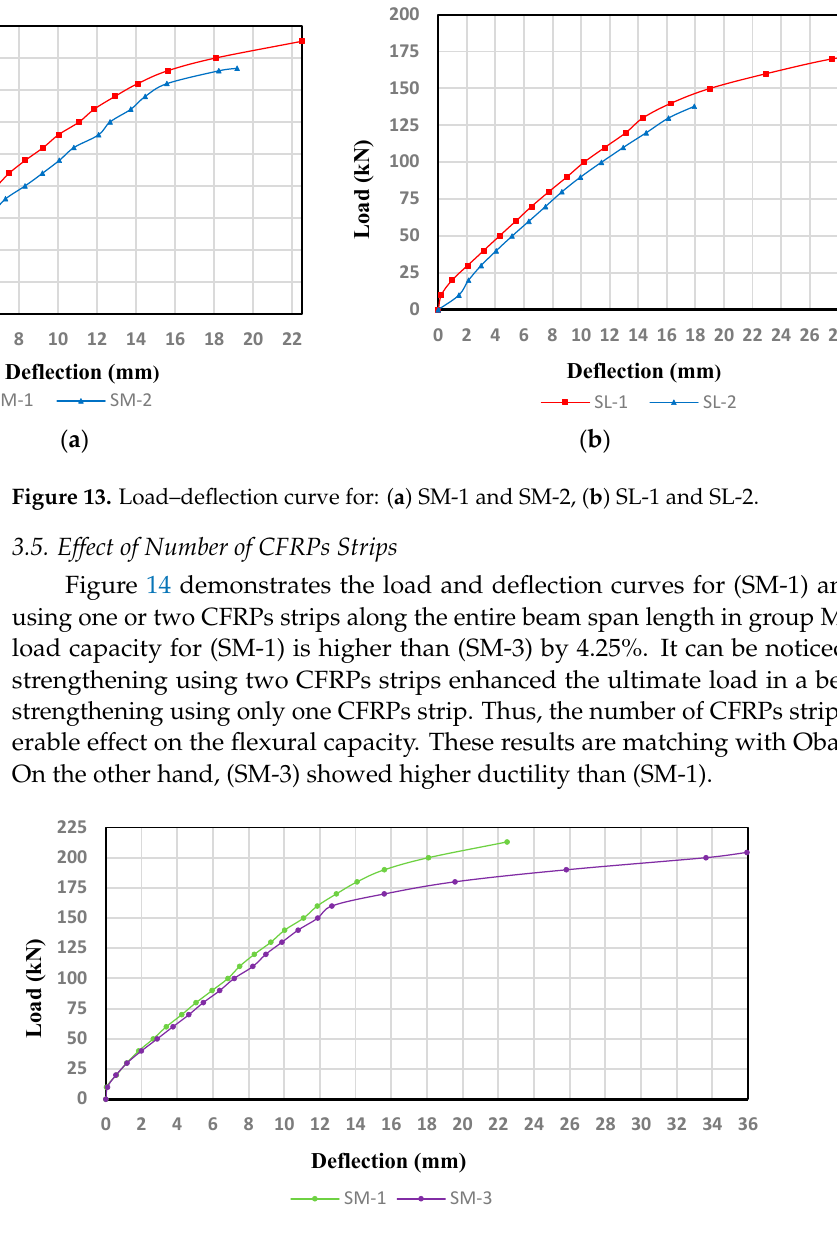
Figure 14. Load–deflection curve for SM-1 and SM-3.